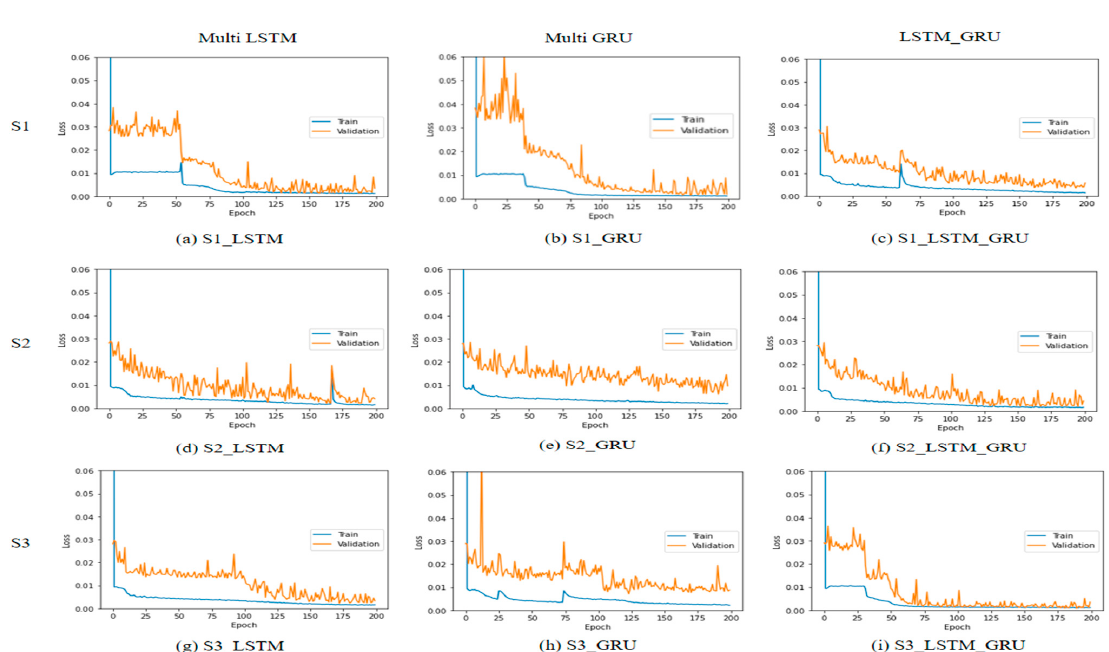
Figure 14. Loss value graph according to epoch during model training by scenario. ( a ) S1_LSTM; ( b ) S1_GRU; ( c ) S1_LSTM_GRU; ( d ) S2_LSTM; ( e ) S2_GRU; ( f ) S2_LSTM_GRU; ( g ) S3_LSTM; ( h ) S3_GRU; and ( i ) S3_LSTM_GRU.